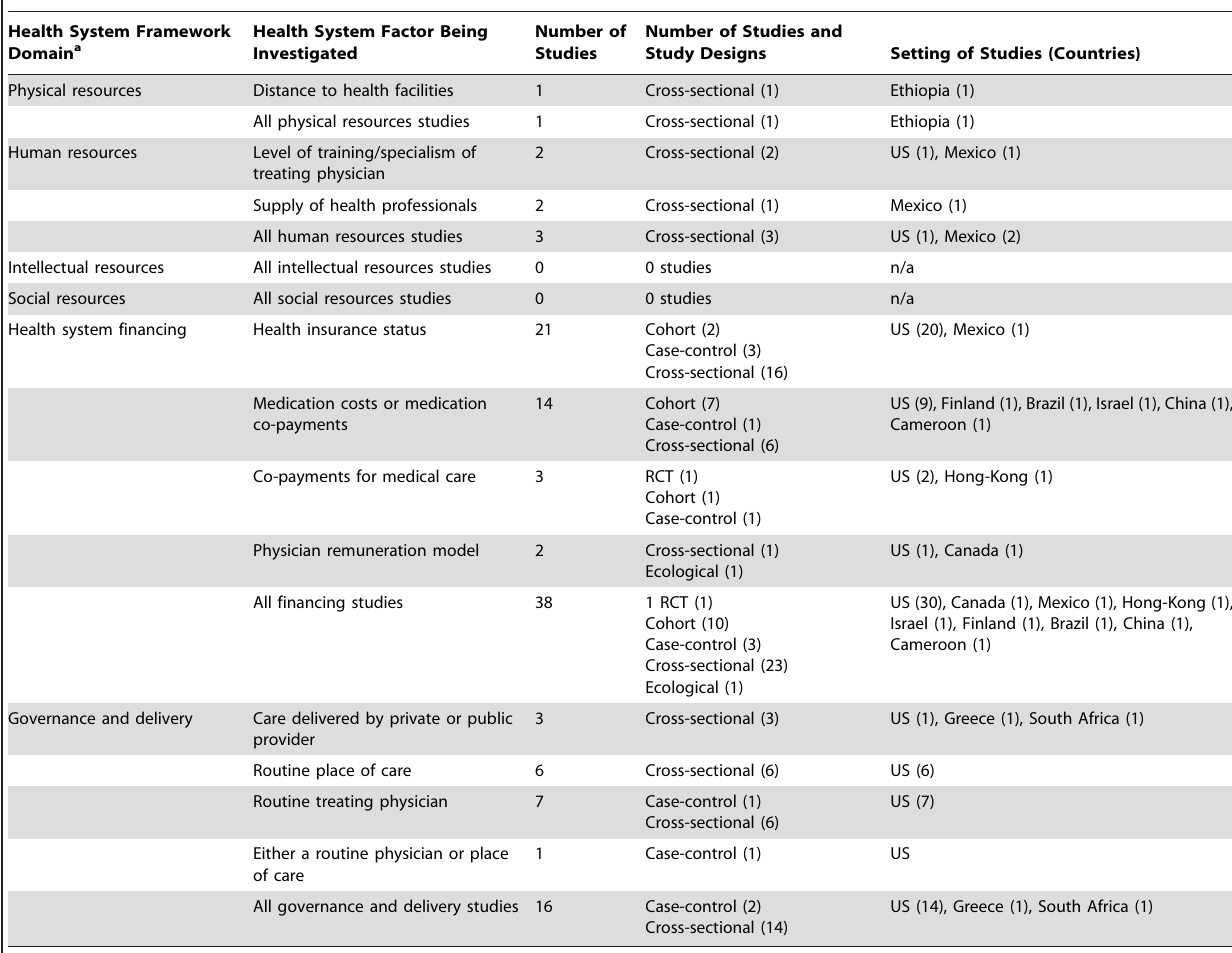
Table 1. Health system arrangements investigated by included quantitative studies, classified by health system